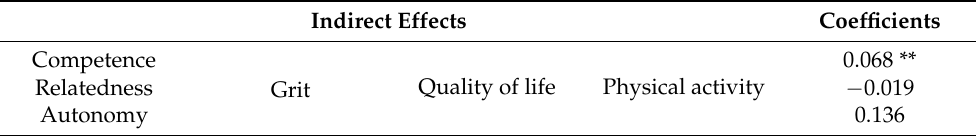
Table 4. The indirect effect of grit on the relationship between BPNs and quality of